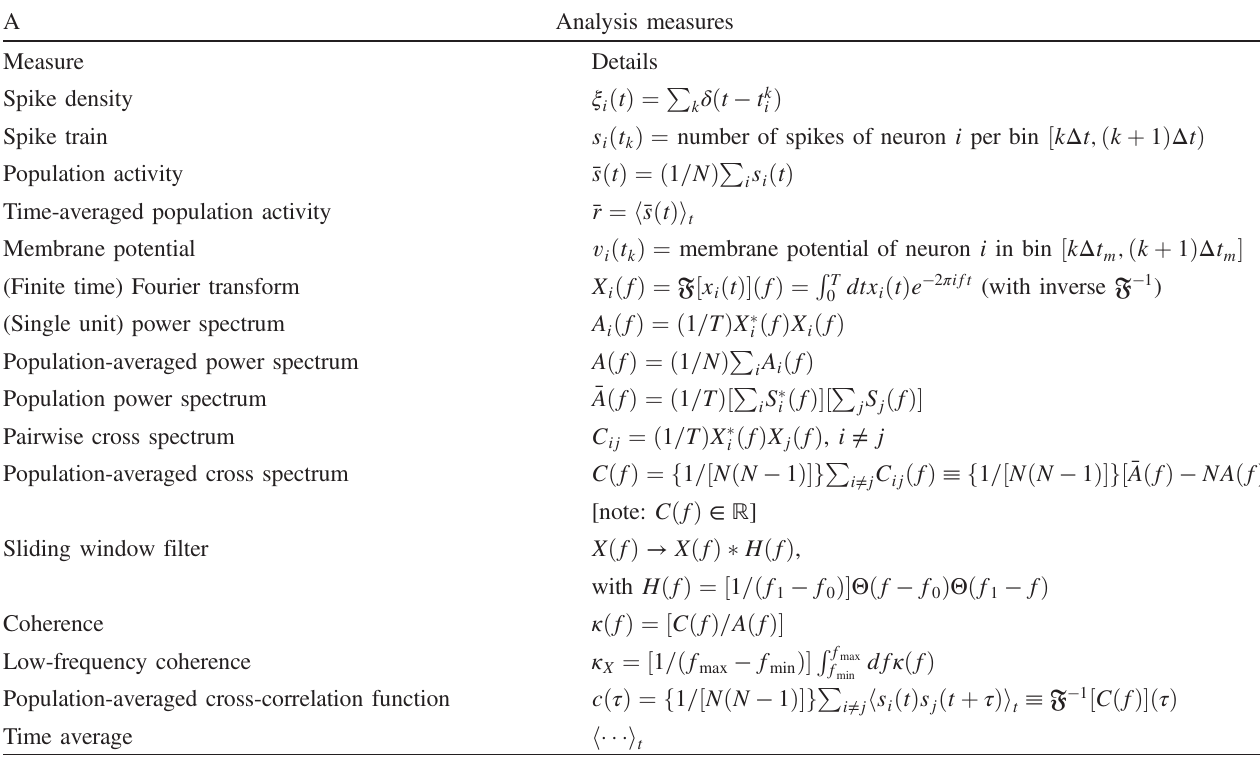
TABLE III. Summary of the data analysis. Here, i ∈ ½ 1 ; N (cid:2) , X ∈ S , V .